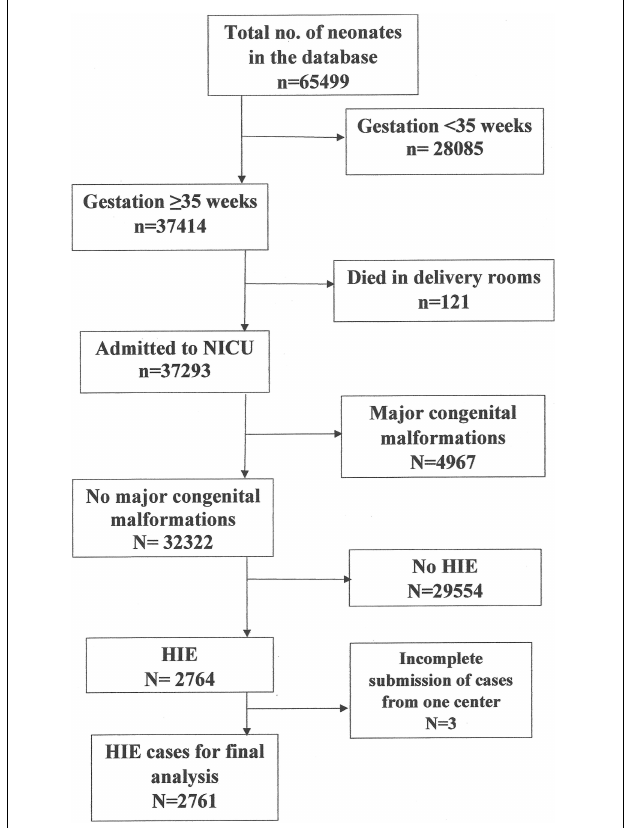
FIGURE 1 | Recruitment